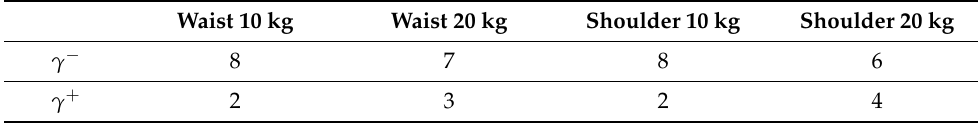
Table 2. Number of subjects γ − for which the exoskeleton use results in a reduced 90th percentile muscle activation ( ρ i < 1) and number of subjects γ + for which the exoskeleton use results in an increased peak muscle activation ( ρ i > 1), for each combination of pulling height (waist and shoulder) and box weight (10 and 20 kg).